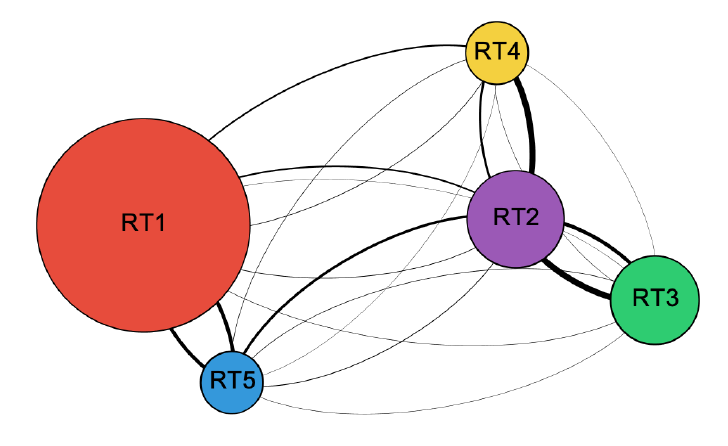
Figure 7. The graph induced by the community detection on the RT directed network, whose adjacency matrix is given in Figure 6. Each super node represents a community: sizes are proportional to the number of accounts in each community. Links’ directions are given